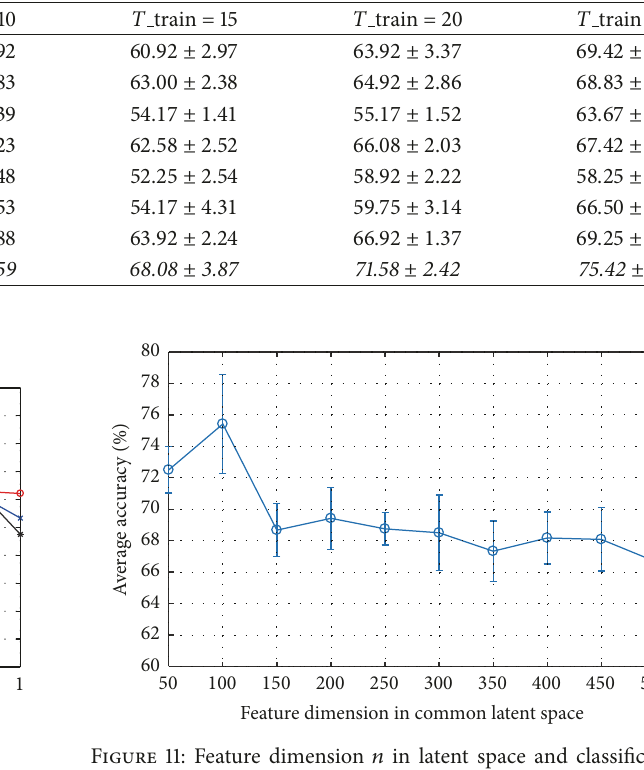
Table 5: Average recognition precision (%) comparison of the proposed method CDFAG with state-of-the-art methods. For each method, the best accuracies of various T train values are shown. The best accuracies of each T train are marked in italics.